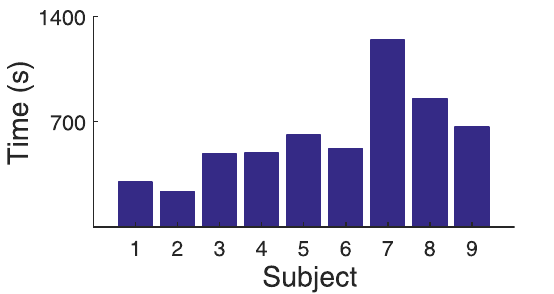
Fig 12. Computational time of M3VR for different subjects. The computational time of M3VR varies among different subjects. The time difference is mainly affected by sizes of the VOIs and the quality of initial registration.